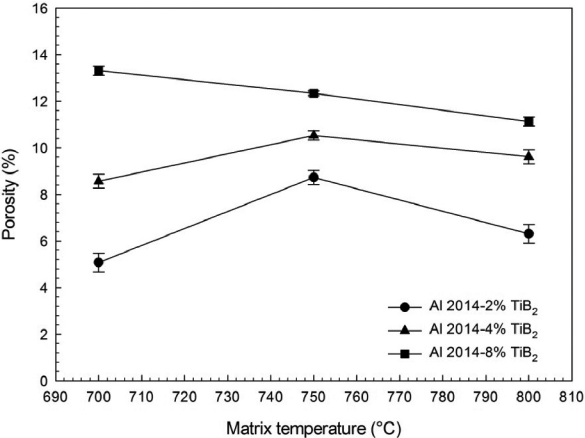
Fig. 5: The variation of the porosity as a function of TiB 2